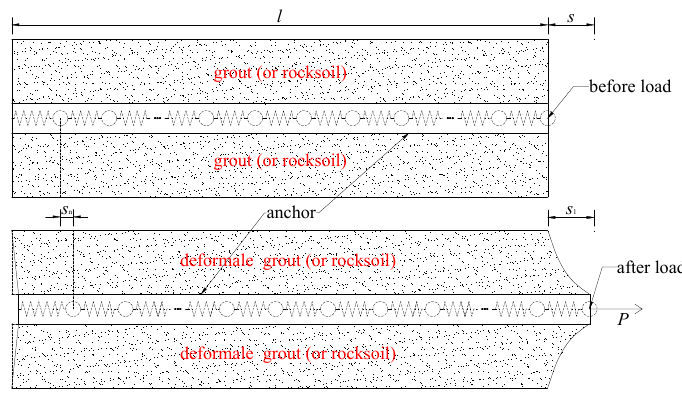
Figure 2. Schematic diagram of discretization of anchor.